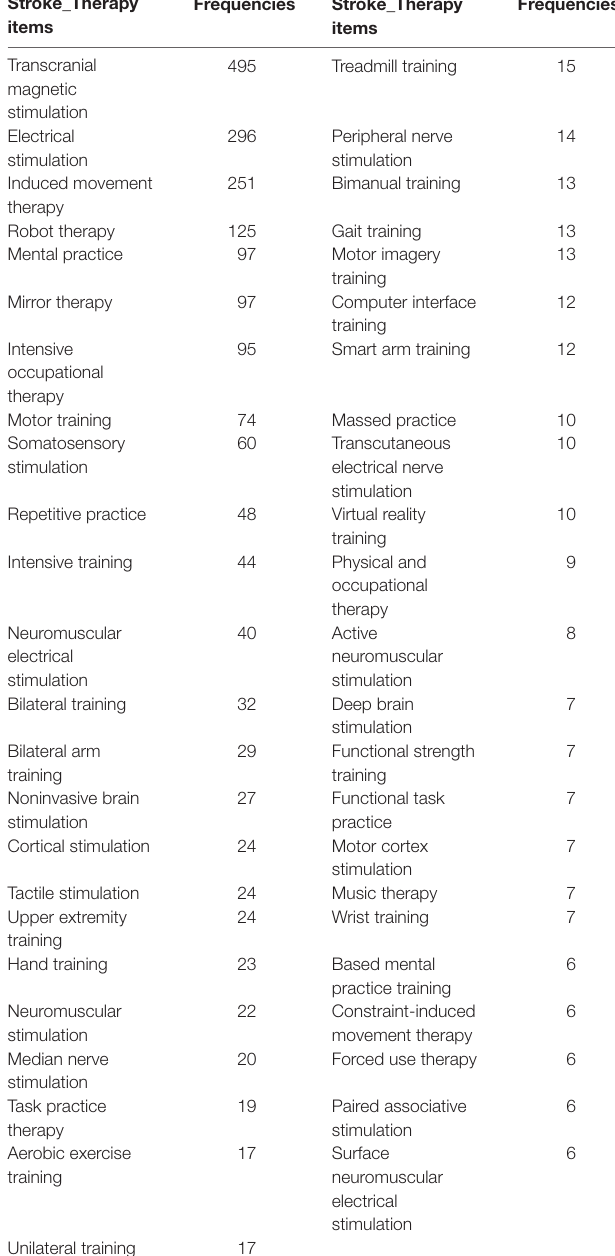
TABLE 2 | Stroke_Therapies dataset items with